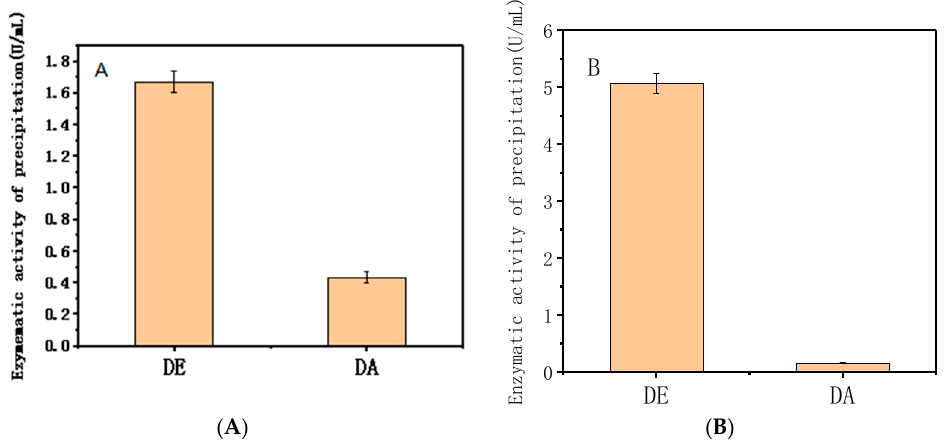
Figure 6. Effect of six-histidine tags in the protein sequence on adsorption ( A ) detected based on same enzyme active, ( B ) detected based on same concentration of protein of enzyme.